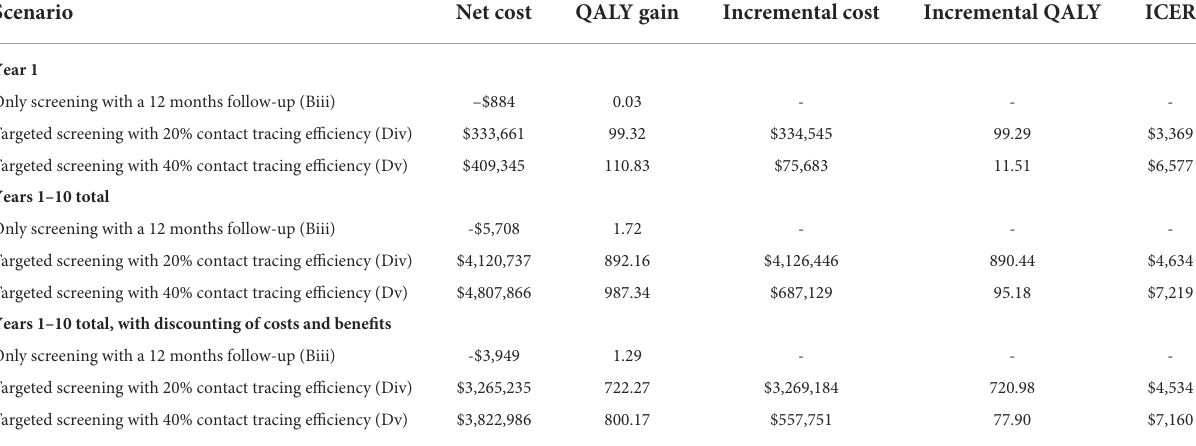
TABLE 6 Results of the cost-effectiveness analysis: ICER league table. Scenario Incremental